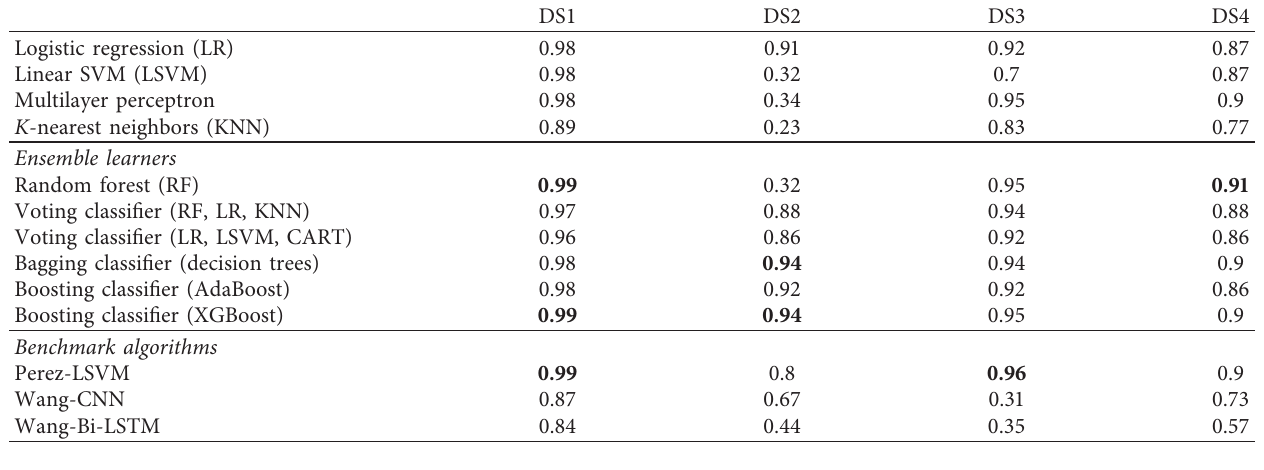
Table 5: F1-score on the 4 datasets.